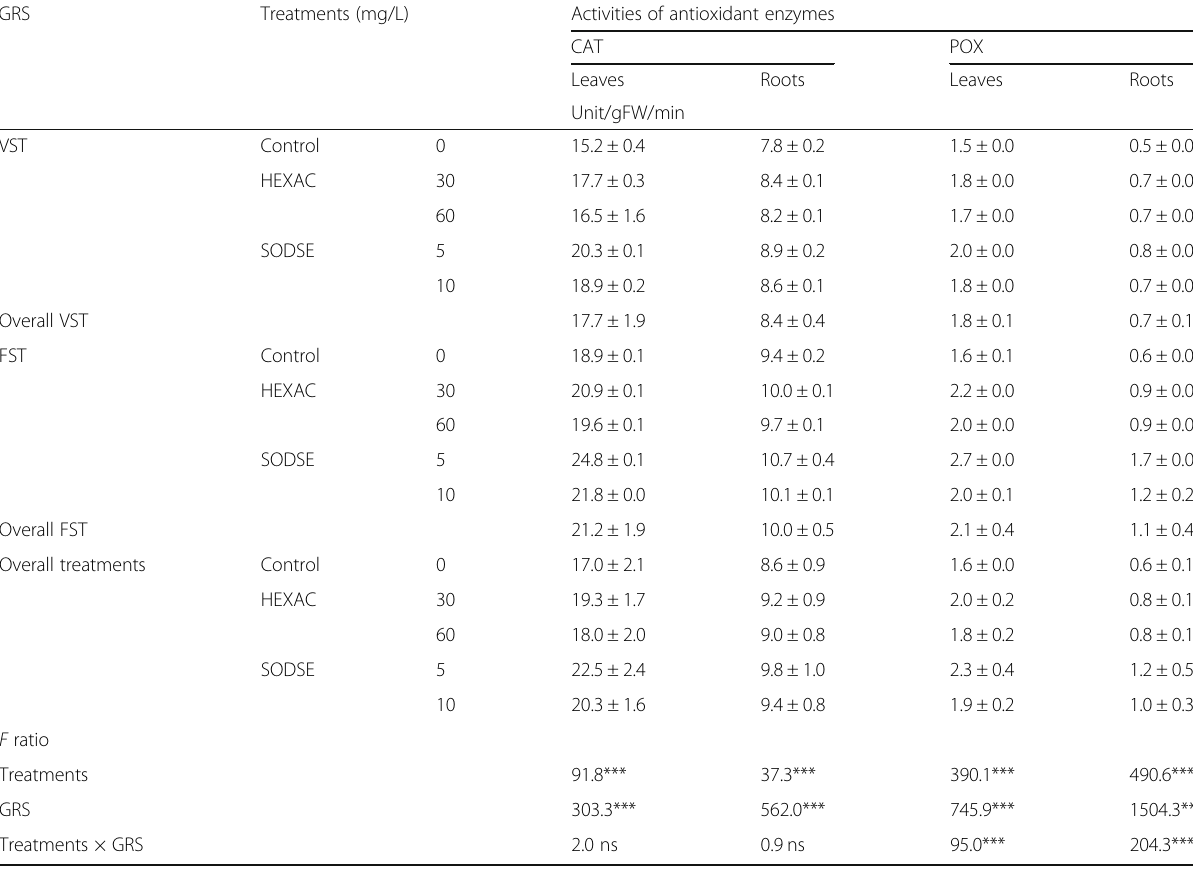
Table 5 Effect of HEXAC or SODSE on the activities of antioxidant enzymes GRS Treatments (mg/L) Activities of antioxidant